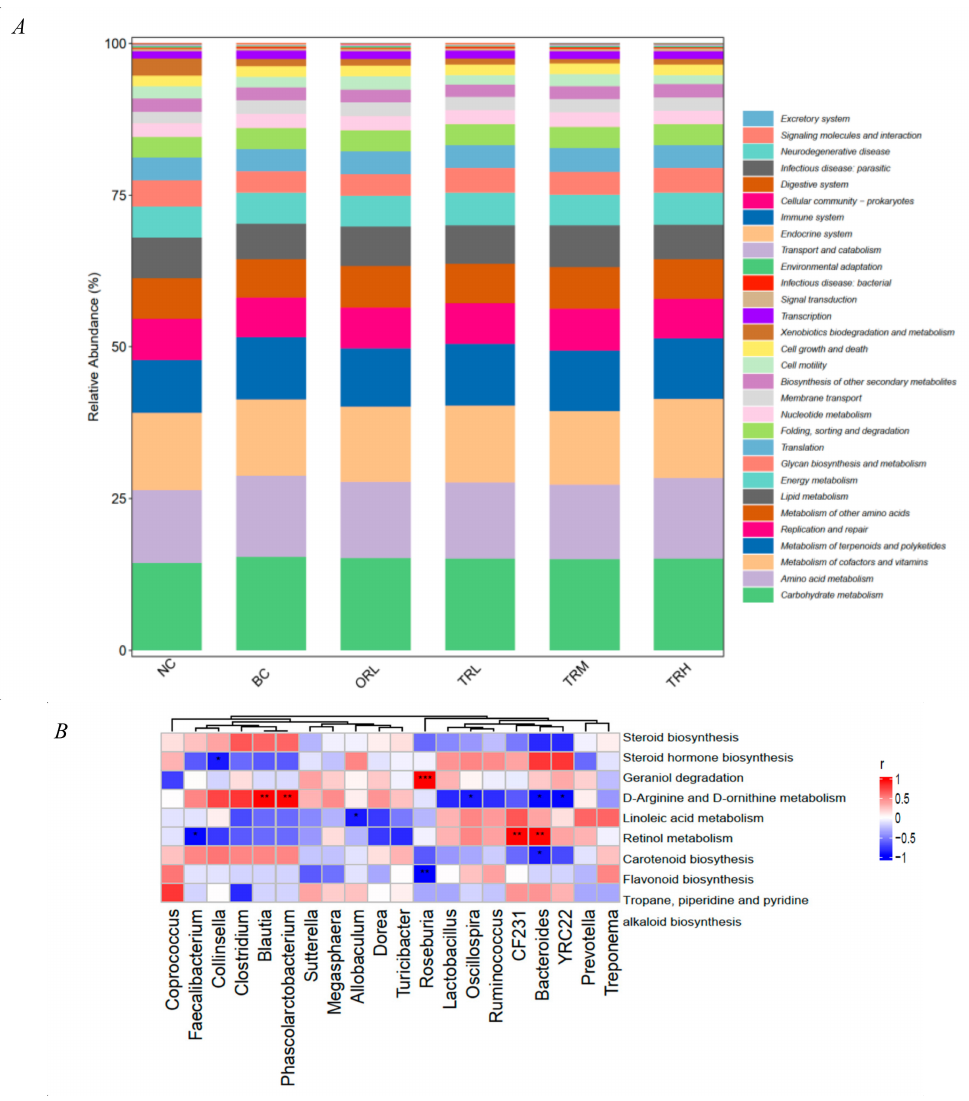
Figure 5. KEGG pathways prediction ( A ) and correlations between the microbiome at genus level and metabolites ( B ) in different groups. NC: Normal control group, chow diet; BC: Blank control group, high-fat diet; ORL: Positive control group, orlistat; TRL: Low-dose group, trilobatin; TRM: Middle-dose group, trilobatin; TRH: High-dose group,